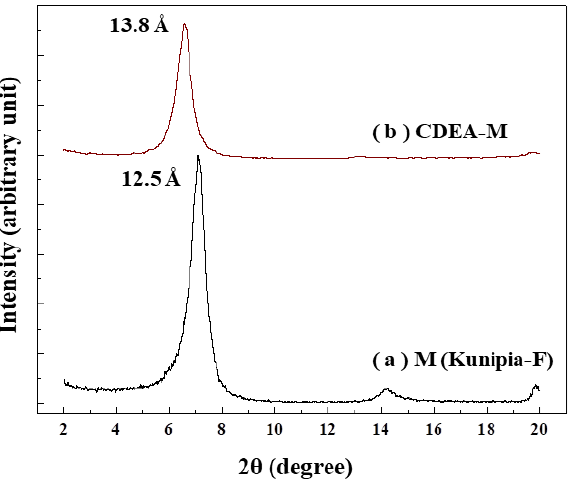
Figure 1. Powder XRD patterns of ( a ) M (Kunipia-F) and ( b ) CDEA-M nanocomposite prepared by solution reaction method.